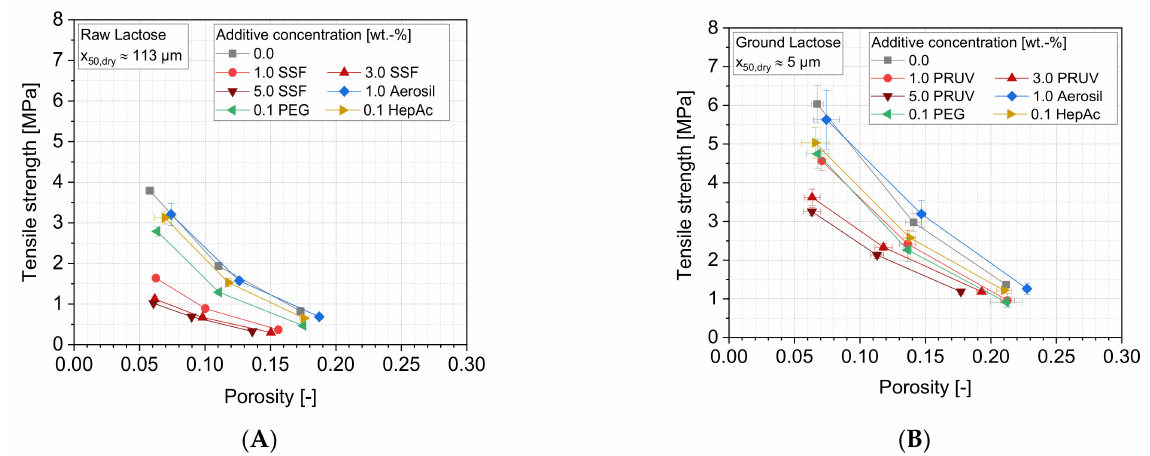
Figure 13. Tensile strength as a function of the tablet porosity for different additives: ( A ) raw lactose and ( B ) ground lactose, n =